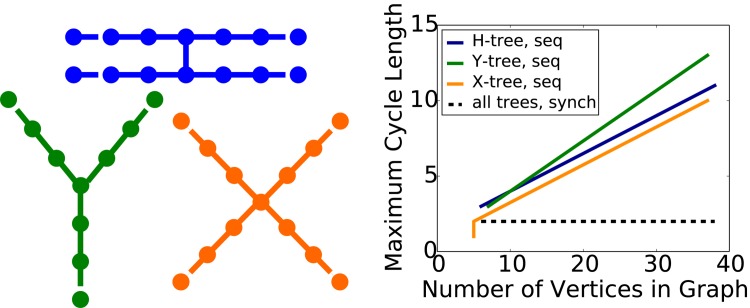
Experimental results generated with GDSC showing the maximum cycle length versus number of graph vertices when the condition Δ = k
10 − k
01 ≤ 1 is minimally violated.The goal is to produce GDSs that generate larger limit cycles than fixed points. The three tree structures on the left were found experimentally, and results were used to prove that there exist graphs with particular structures that produce limit cycles of any specified size for sequential update (see plot at right). Functional forms of these relationships are given in [8]. These structures differ in the smallest limit cycles they can produce and in the maximum cycle size for a given number of vertices. Data for the sequential update scheme are presented as solid lines; limit cycle size increases without bound for increasing graph size. Data for synchronous update, for all graph structures, is the dashed black curve.